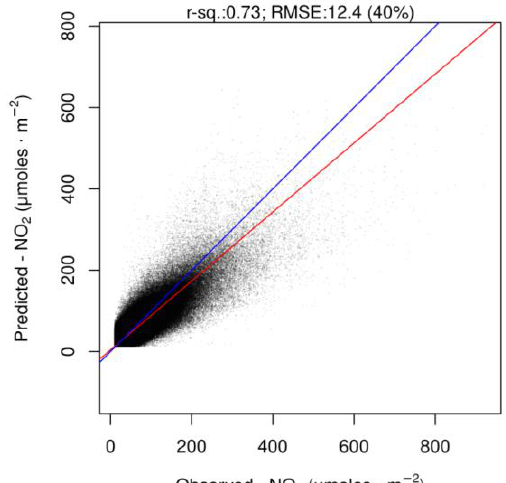
Figure 4. Regression over all NO2 values from image pairs merged together. Red line is the regression line, blue line is the 1:1 slope